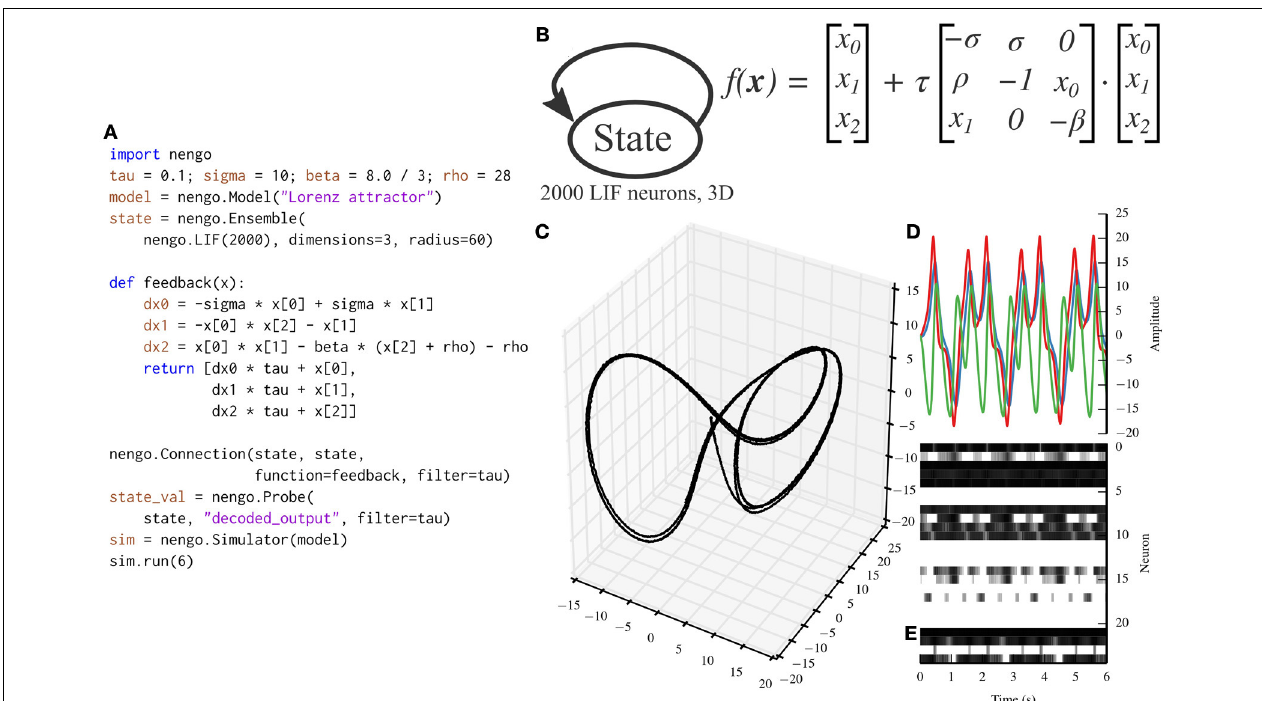
FIGURE 5 | A Lorenz attractor implemented with Nengo. (A) Nengo code to build and simulate the model for 6s. (B) Diagram depicting the model. The state ensemble is recurrently connected with a complex function implementing the dynamics of the Lorenz attractor. Note that this population does not receive any input that might drive its initial value; instead, the initial value is determined by the baseline firing of the 2000 leaky integrate-and-fire neurons that make up the state